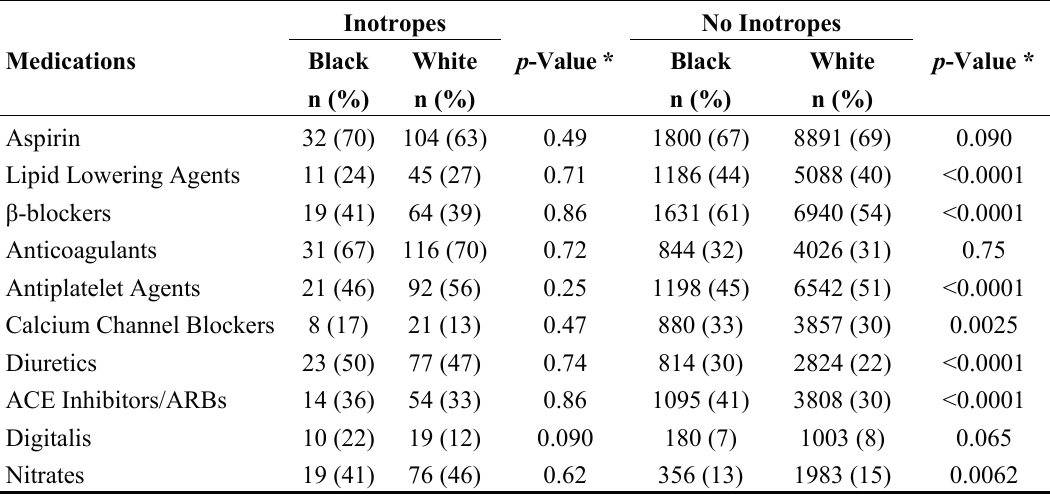
Table 2. Preoperative medications.